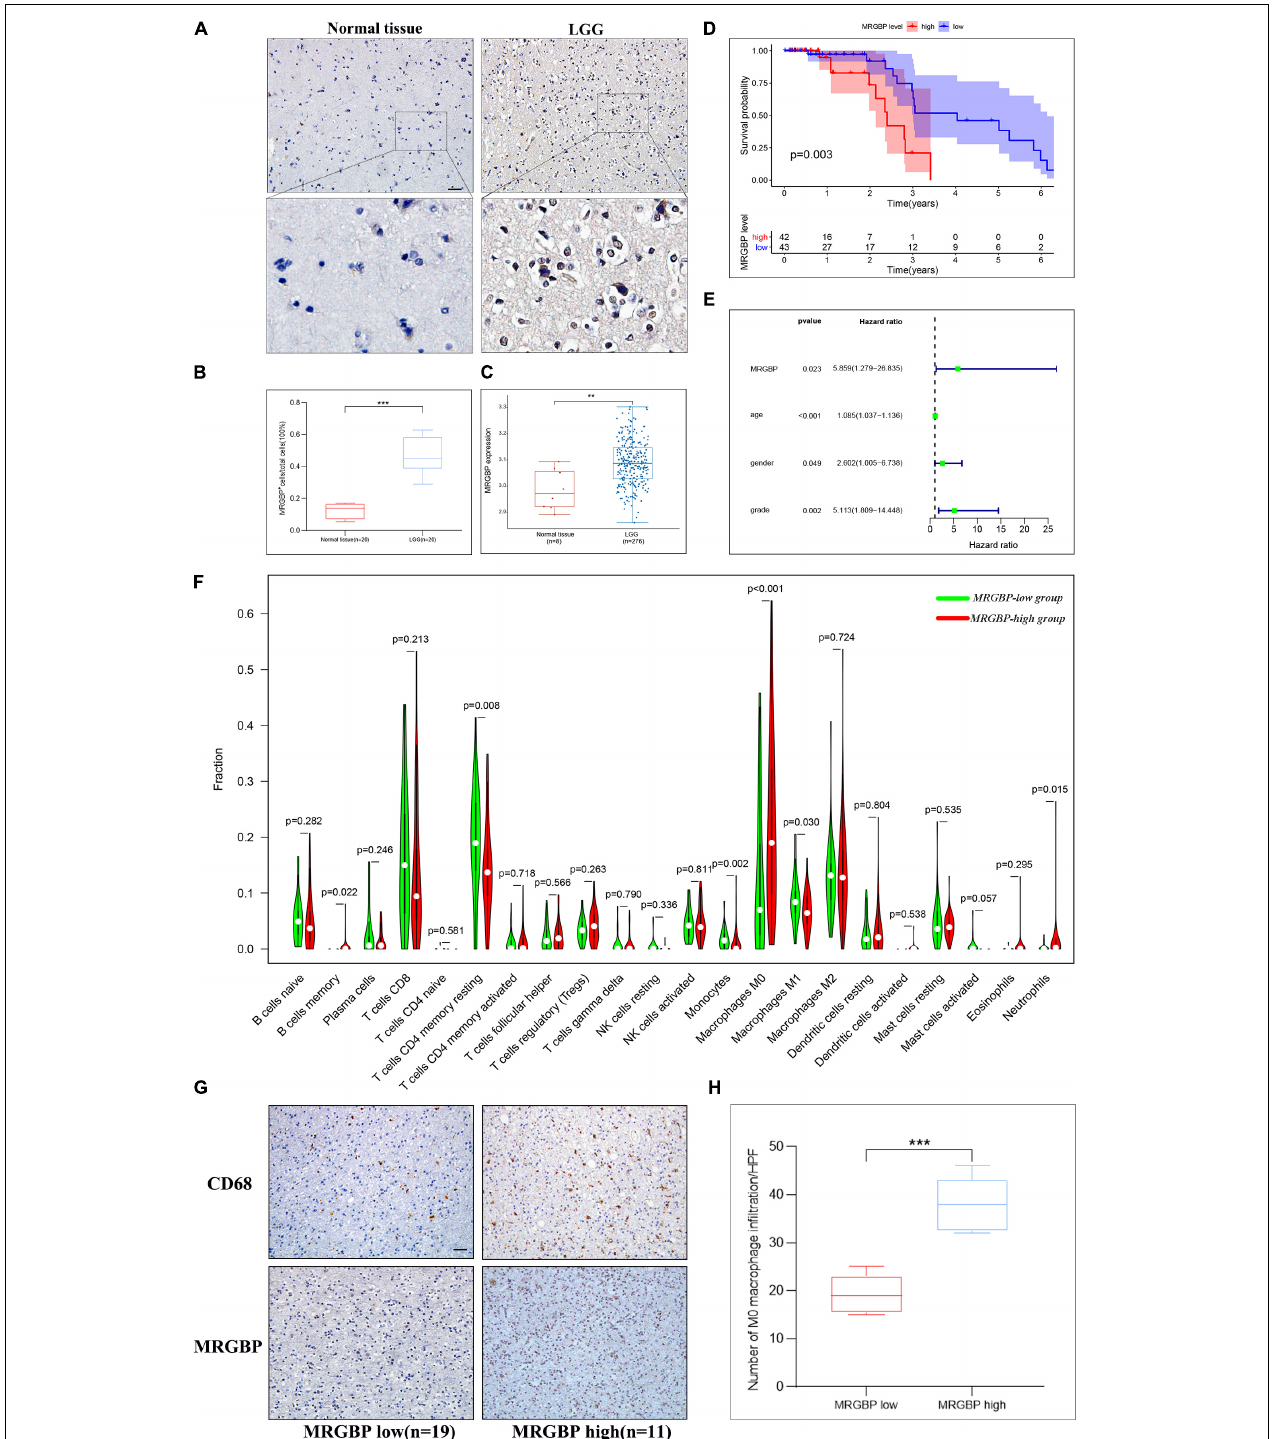
FIGURE 12 | Preliminary verification of MRGBP signature in LGG. (A) Representative images of MRGBP immunohistochemistry in LGG. The picture below shows a 16 × magnification. scale bars = 50 µ m. (B) Quantification analysis showed higher MRGBP expression in LGG. (C) Validation of MRGBP expression by GSE16011. (D) Association between MRGBP expression and prognosis in GSE4412. (E) Univariate independent prognostic analysis in GSE4412. (F) Relative abundance of tumor-infiltrating immune cells in the MRGBP low expression group vs. MRGBP high expression group. (G) Representative images of CD68 immunohistochemistry in the MRGBP low expression group and MRGBP high expression group. scale bars = 50 µ m. (H) Quantification analysis showed higher levels of M0 macrophage infiltration in the MRGBP high expression group (*** P < 0.001, ** P < 0.01).